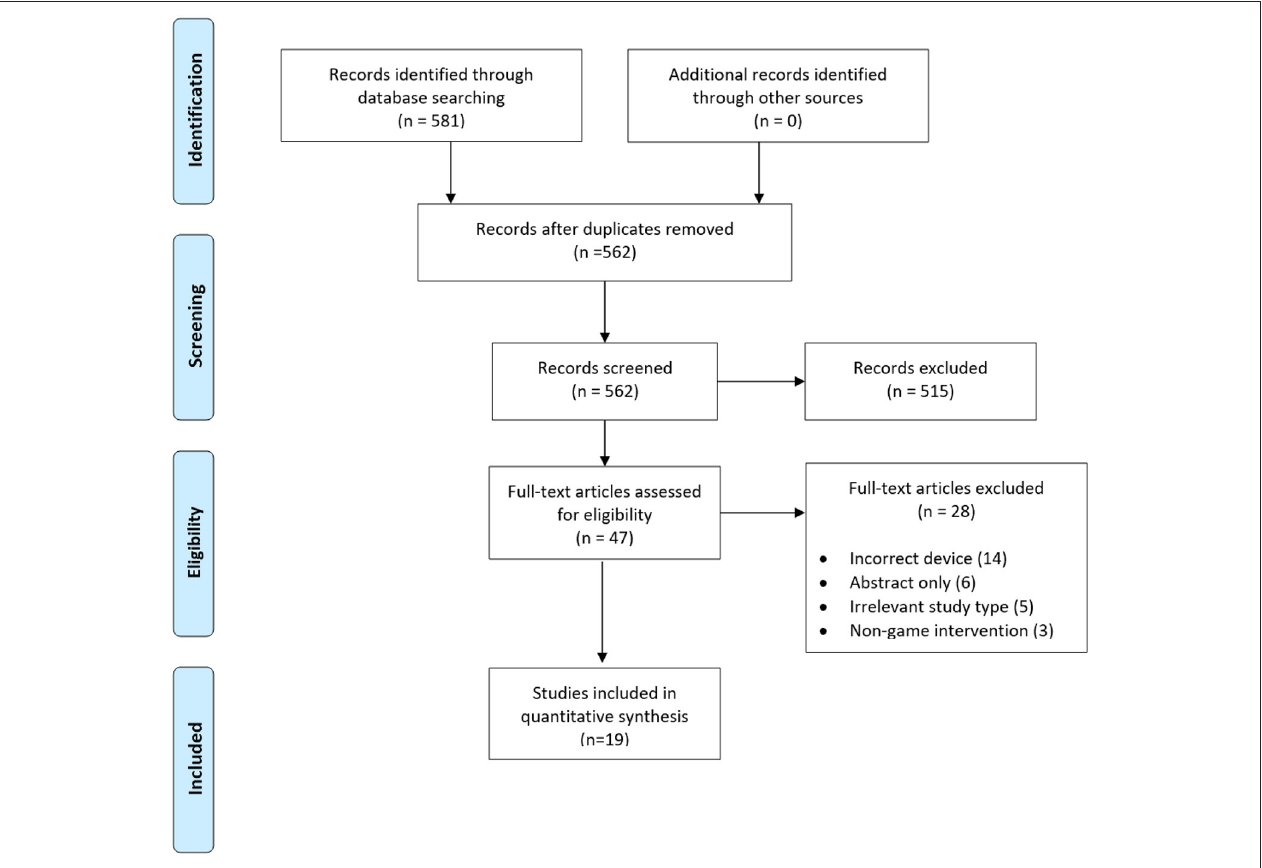
FIGURE 1 | PRISMA flowchart of the study selection